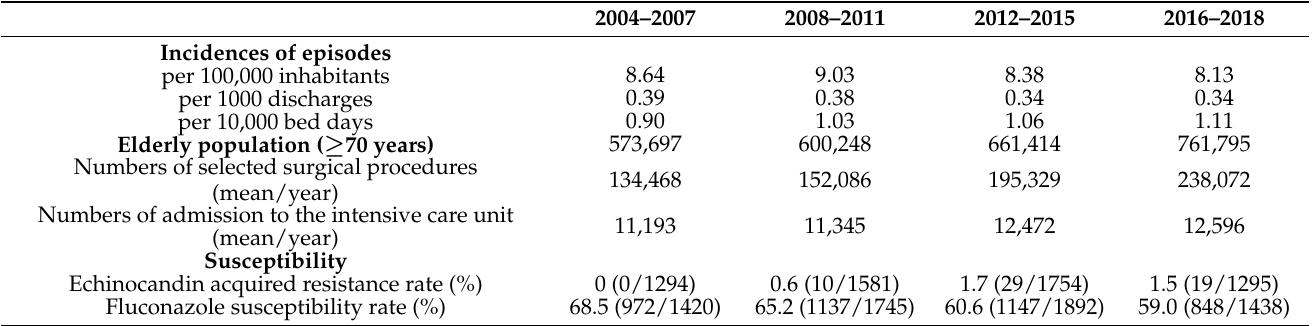
Table 2. Data in a four-period